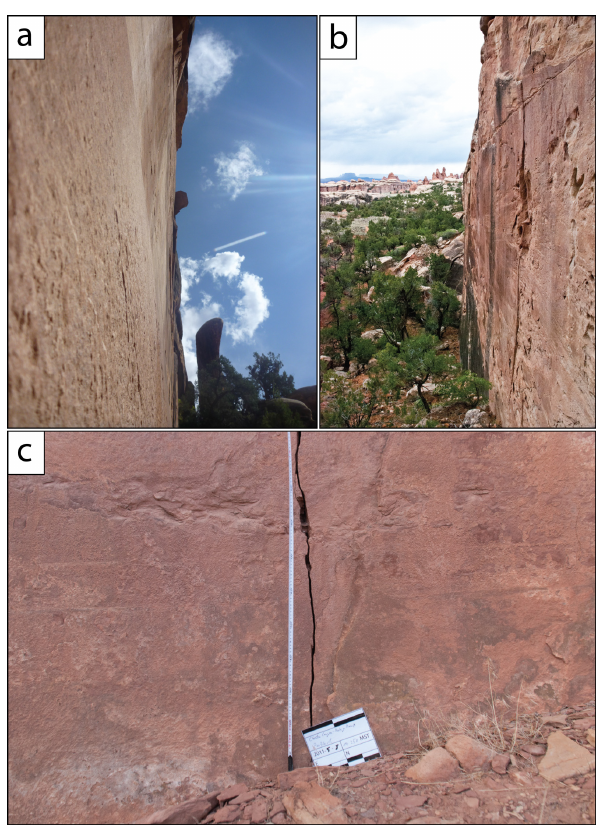
Figure 7. Widely unweathered surfaces of joints that accommo- dated offset due to underlying faulting show no slickenlines or tool marks at (a) northern Devil’s Pocket, (b) southern end of Devil’s Pocket and (c) Devil’s Lane relay.